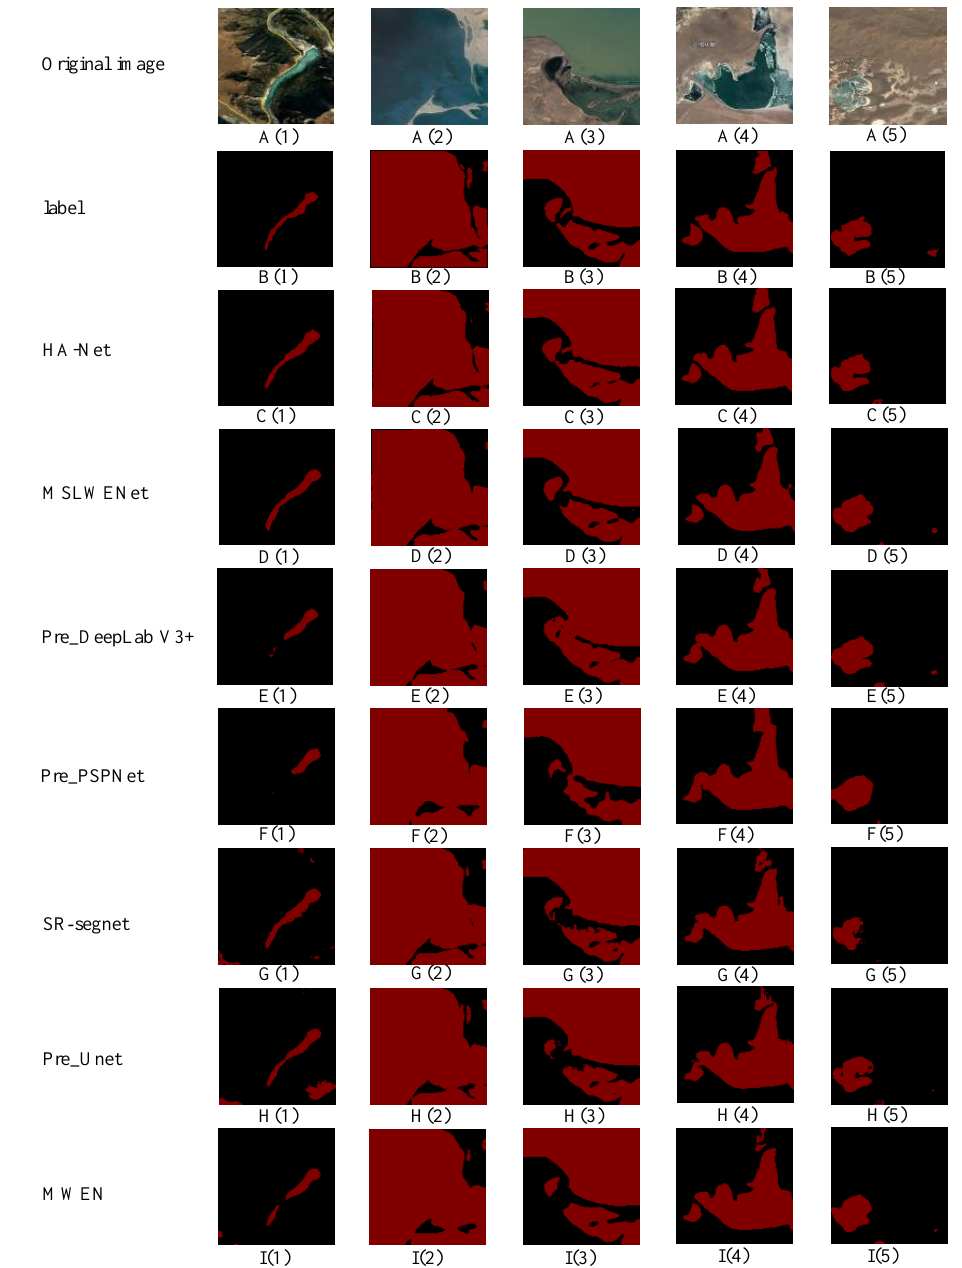
Figure 10. The visualization results of comparing the proposed method against other methods in boundary regions. ( A ( 1 )– A ( 5 )) are the raw images in the test set; ( B ( 1 )– B ( 5 )) are the ground truths to which the raw images correspond; ( C ( 1 )– C ( 5 )), ( D ( 1 )– D ( 5 )), ( E ( 1 )– E ( 5 )), ( F ( 1 )– F ( 5 )), ( G ( 1 )– G ( 5 )), ( H ( 1 )– H ( 5 )), and ( I ( 1 )– I ( 5 )) are the extracted results of HA-Net, MSLWENet, Pre_DeepLab V3+, Pre_PSPNet, SR-segnet, Pre_Unet, and MWEN,